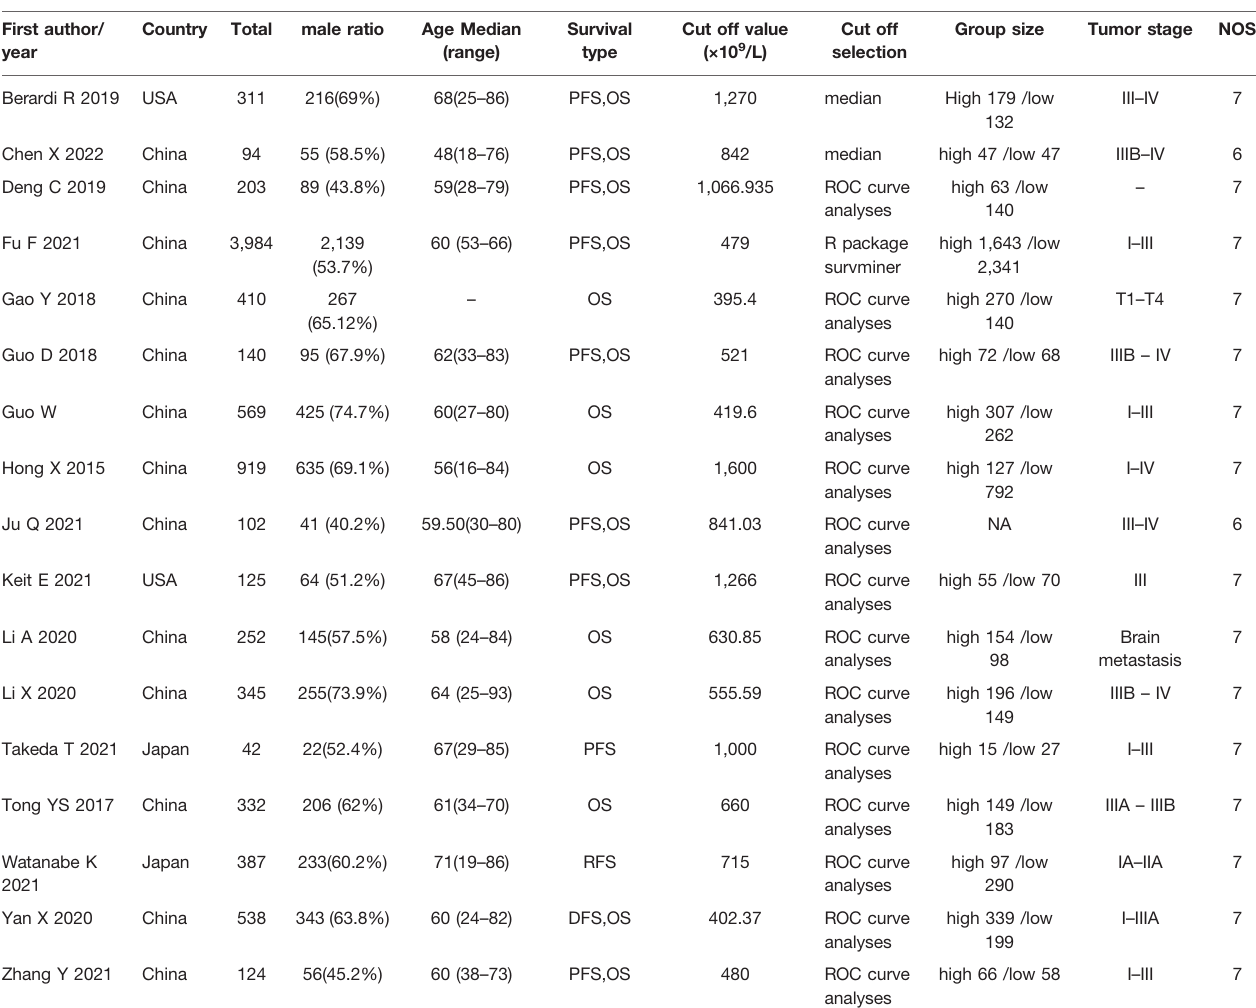
TABLE 1 | Characteristics of included